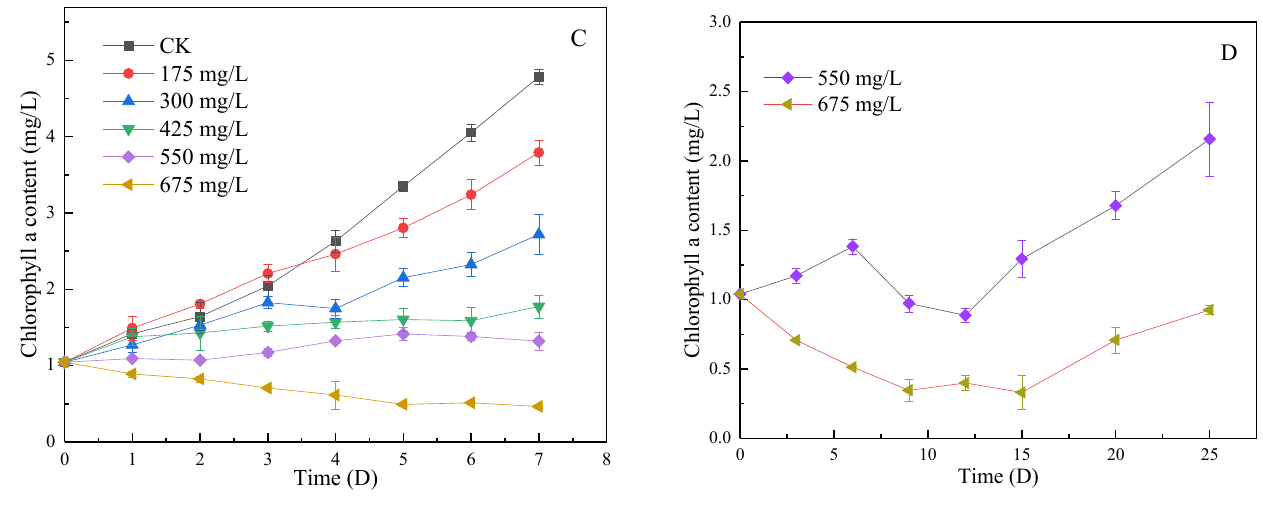
Figure 3. Short-term and long-term Chl- a concentration change of lag phase and log phase: ( A ) short-term Chl- a concentration change of lag phase; ( B ) long-term Chl- a concentration changes of lag phase; ( C ) short-term Chl- a concentration change of log phase; ( D ) long-term Chl- a concentration changes of log phase.